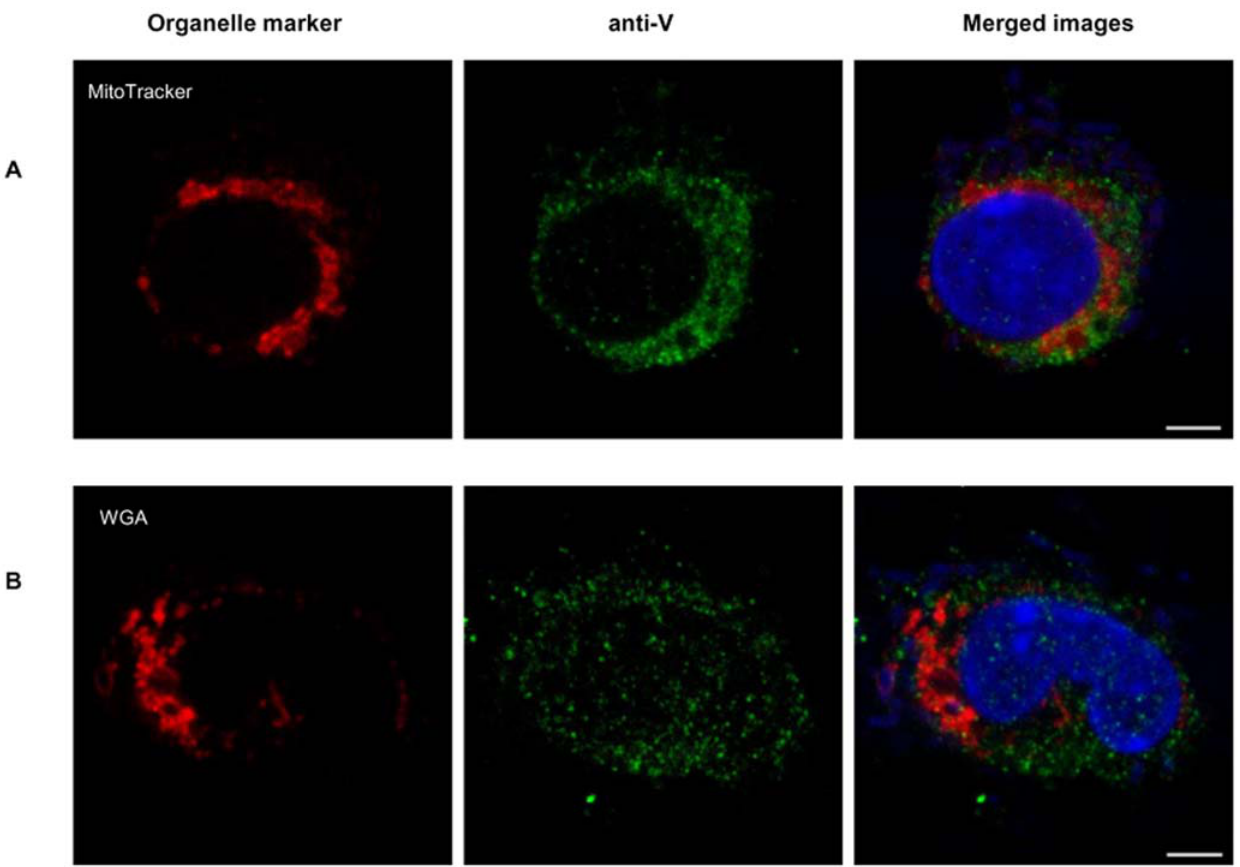
Figure 2. Trafficking of V as detected by ICM. (A) M W s were infected for 3 h with CO92 pPst- pgm- and then stained with MitoTracker and FITC conjugated anti-V Ab followed by Hoechst 33342 dye. (B) M W s were stained with Alexa Fluor 594-labeled WGA, infected with CO92 pPst- pgm- for 4 h, and stained with FITC anti-V Ab, followed by secondary staining with FITC-labeled anti-mouse IgG, and tertiary staining with Alexa Fluor 488 labeled anti-rabbit IgG Abs. M W s were also stained with Hoechst 33342 Dye. All images were captured with a BioRad 2000MP multiphoton confocal system attached to a Nikon TE300 inverted microscope and merged in last panel. Co-localization was defined by an overlap of red and green staining, suggesting V was present in mitochondria and Golgi, after 3 and 4 h of infection, respectively. Scale bar=5 m m.